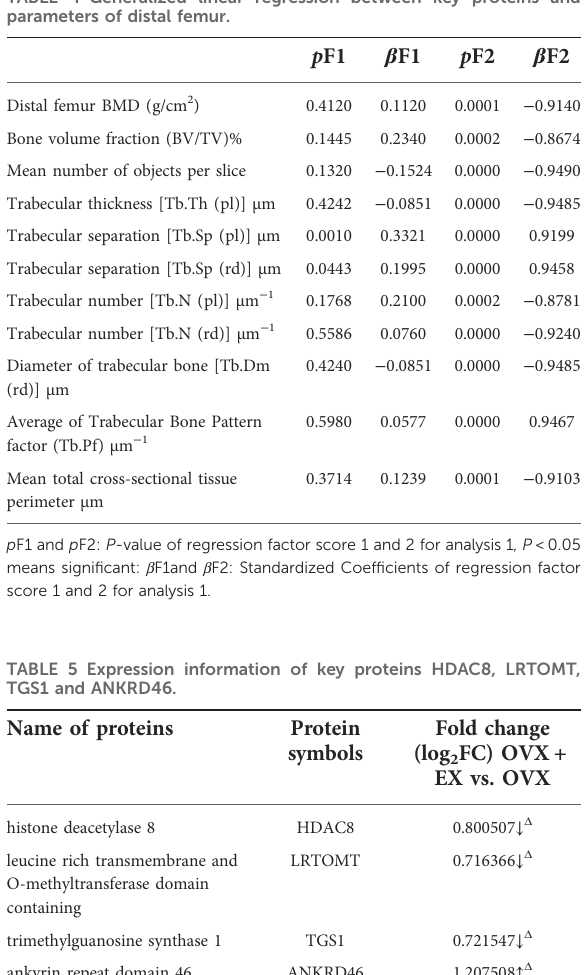
TABLE 4 Generalized linear regression between key proteins and parameters of distal femur.